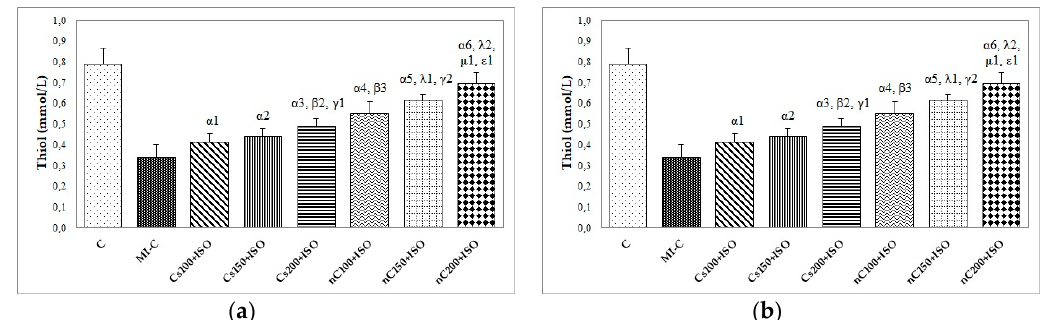
Figure 8. Distribution of antioxidant capacity in the myocardial tissue: ( a ) Thiol and ( b ) total antioxidant capacity (TAC) by groups. C = control; MI-C = isoproterenol without any pre-treatment ; Cs = curcumin solution, in doses of 100 mg/kg bw (Cs100), 150 mg/kg bw (Cs150), and 200 mg/kg bw (Cs200); nC = curcumin nanoparticle solution, in doses of 100 mg/kg bw (nC100), 150 mg/kg bw (nC150), and 200 mg/kg bw (nC200). The letter-number codes correspond to the p-values < 0.05: α as compared with MI-C, β as compared with CS100+ISO, γ as compared with CS150+ISO, λ as compared with nC100+ISO, μ as compared with nC150+ISO, ε as compared with Cs200+ISO.